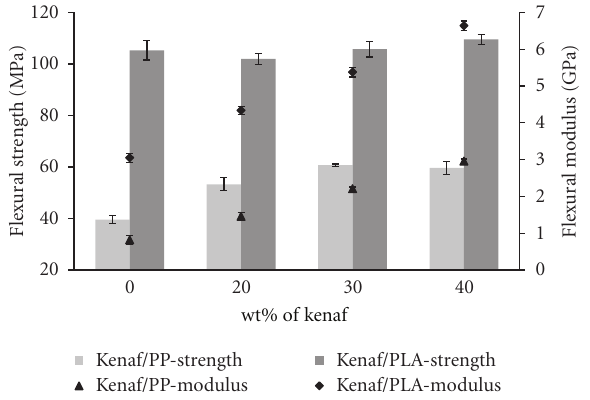
Figure 1: Flexural modulus and strength of kenaf/PP and kenaf/ PLA composites as a function of kenaf content.